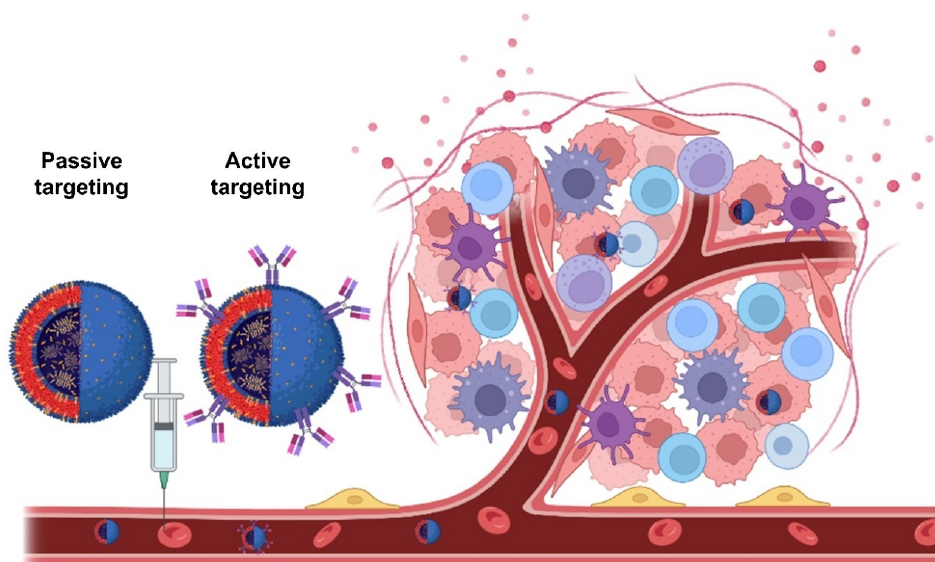
Figure 8. Comparison of passively versus actively targeted nanomedicines.